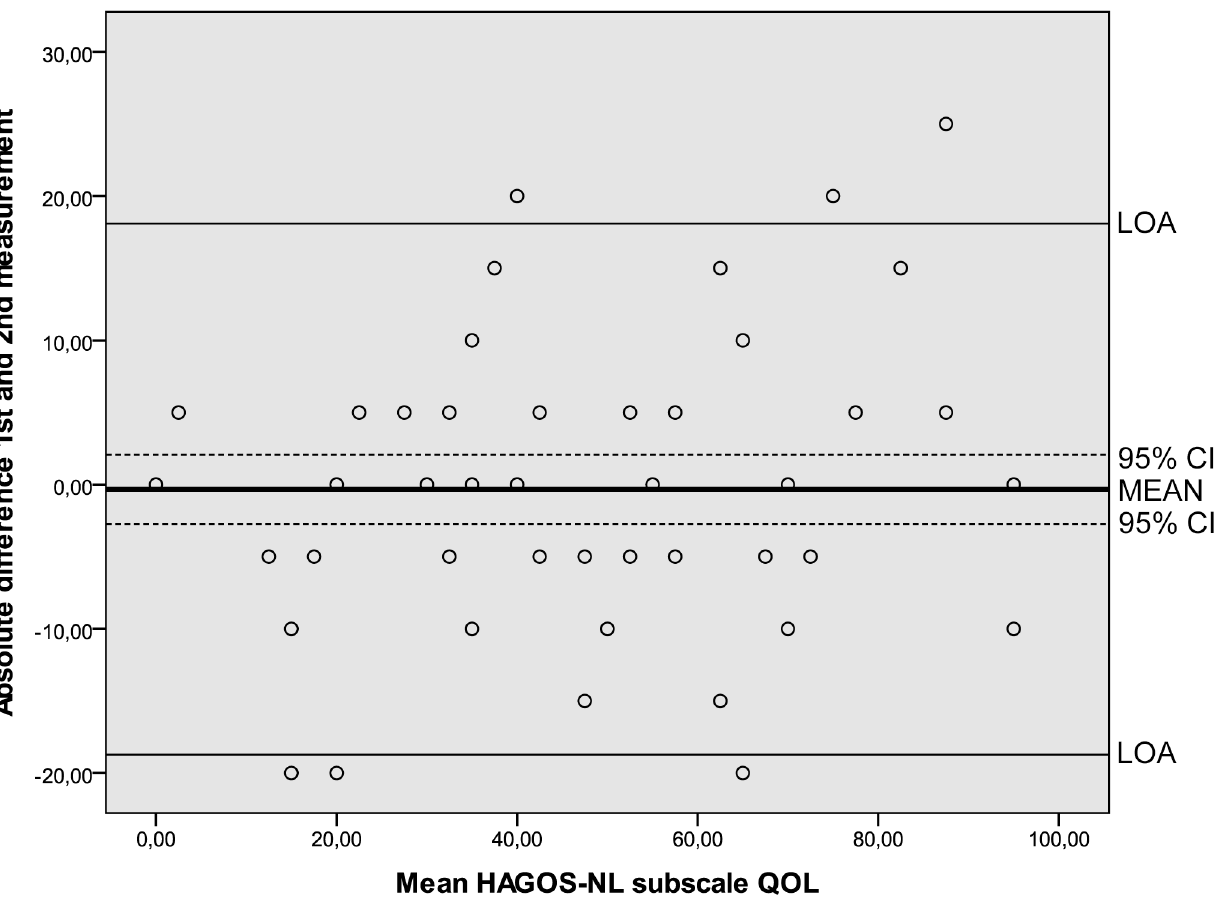
Fig 7. Bland and Altman graph of HAGOS subscale Quality of Life . Abbreviations: HAGOS, Copenhagen Hip And Groin Outcome Score; LOA, limits of agreement; QOL, Quality of life; 95% CI, 95% confidenceinterval.